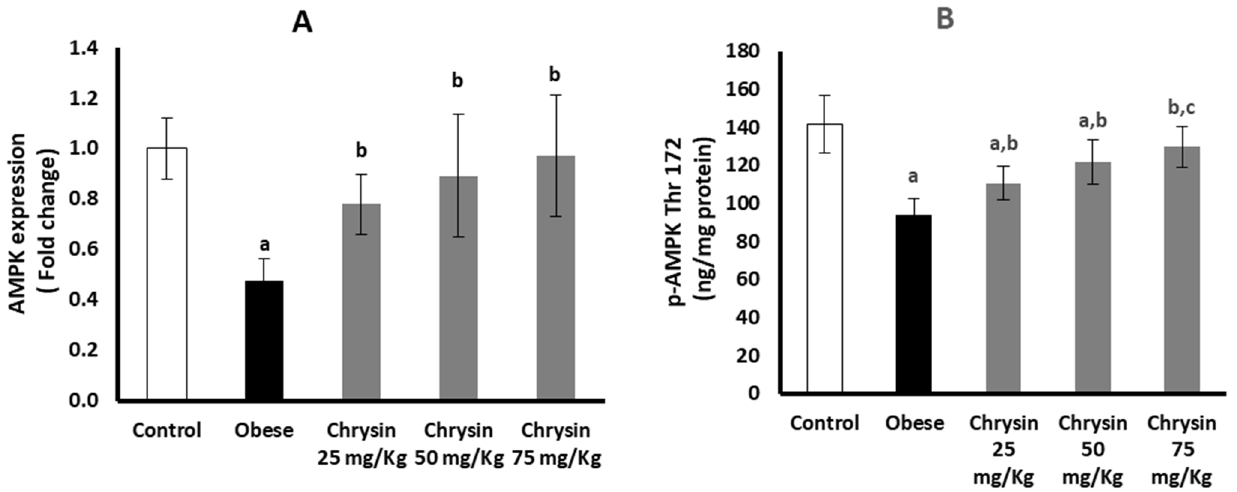
Figure 1. Changes in the hepatic expression of AMPK at mRNA ( A ) and phosphorylated protein ( B ) levels in the obese rats untreated or treated with different doses of chrysin. Data presented as Mean ± SD. a, significantly different from the control group; b, significantly different from the obese group; and c, significantly different from the group treated with chrysin 25 mg/kg, using ANOVA and p < 0.05.